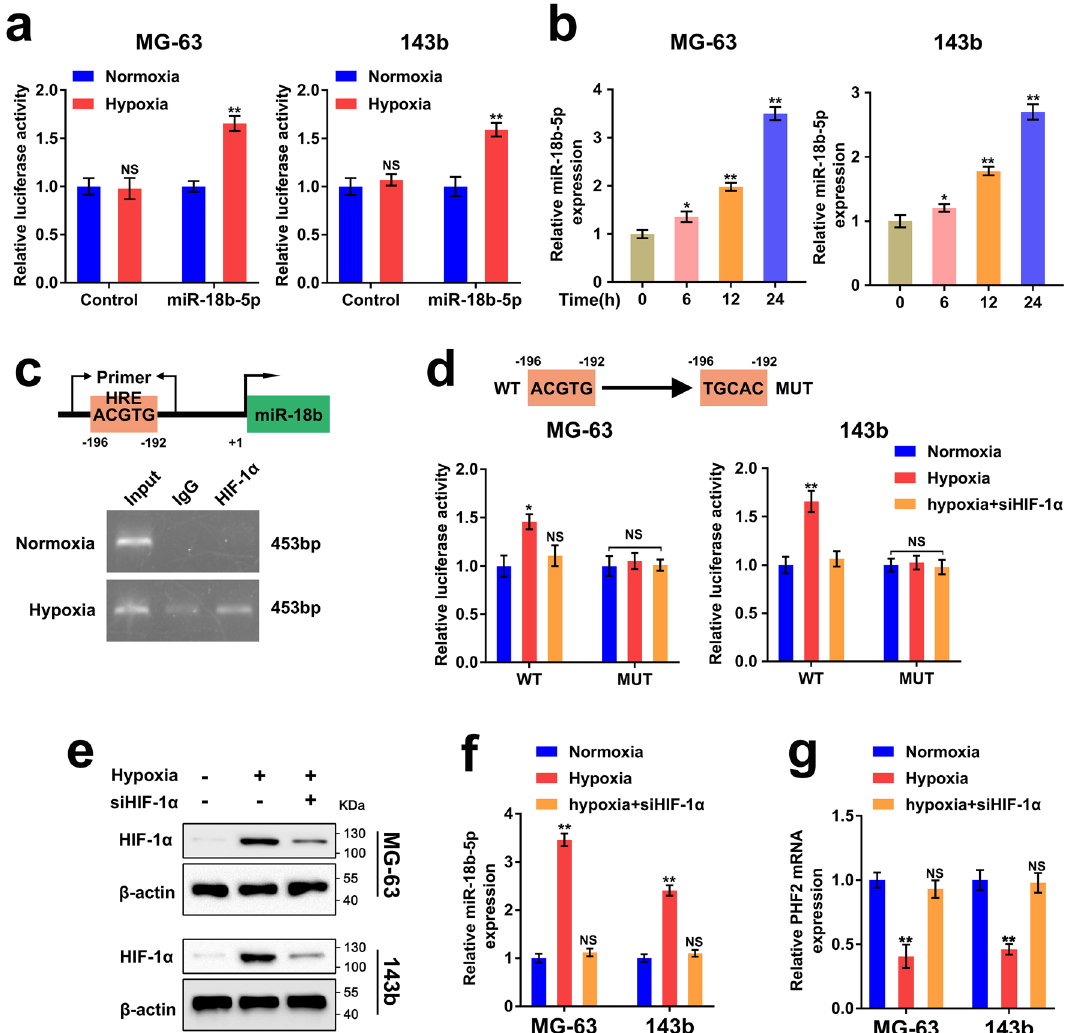
Figure 5. Hypoxia-driven HIF-1α is critical for upregulation of miR-18b-5p in OS. ( a ) The luciferase reporter assay accessed luciferase activity of MG-63/143b cells transfected with luciferase reporter plasmid carrying miR- 18b promoter sequence or scrambled vector under normoxia and hypoxia. ( b ) RT-qPCR assay showed miR- 18b-5p expression in MG-63/143b cells cultured under hypoxia for 0 h, 6 h, 12 h and 24 h. ( c ) (Up) Schematic diagram showed the predicted HRE site on the promoter of miR-18b. (Down) ChIP assay using antibodies against HIF-1α or IgG were performed to validate the binding of HIF-1α on the promoter of miR-18b. ( d ) The luciferase reporter assay accessed luciferase activity of MG-63 and 143b cells transfected with luciferase reporter plasmid carrying WT- miR-18b or MUT- miR-18b, siRNA targeting HIF-1α and negative control under normoxia or hypoxia. ( e ) Western blotting assay accessed protein level of HIF-1α in MG-63/143b cells transfected with siRNA targeting HIF-1α and negative control under normoxia or hypoxia. ( f,g ) RT-qPCR assay showed the expression of miR-18b-5p and PHF2 mRNA in MG-63/143b cells transfected with siRNA targeting HIF-1α and negative control under normoxia or